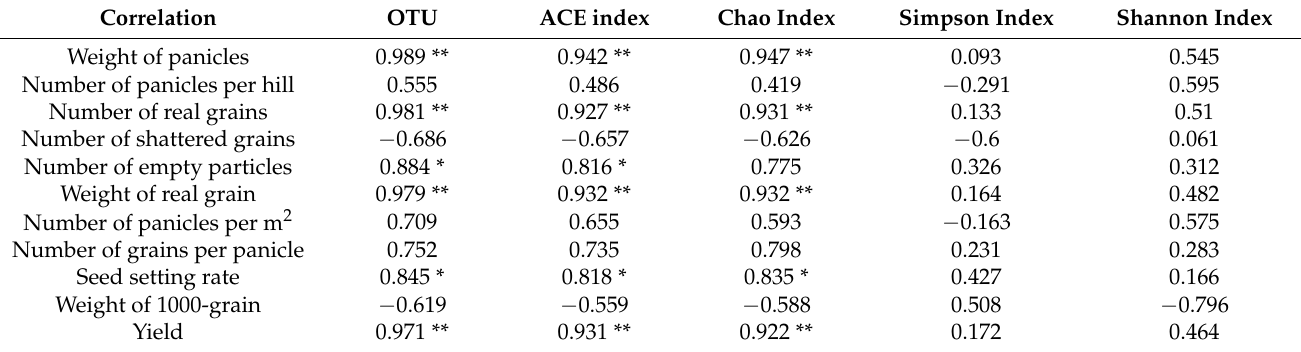
Table 8. Correlation between rice yield and alpha diversity of soil bacteria.